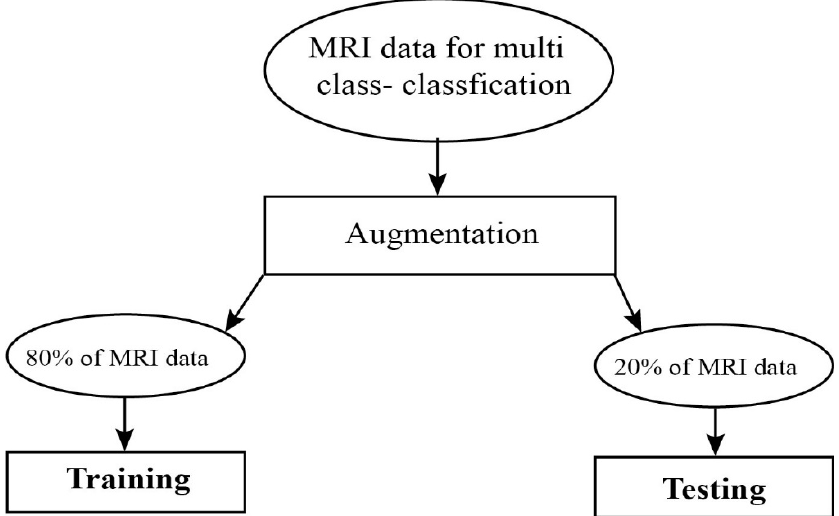
Figure 2. Proposed model data flow chat. Table 4. Proposed model confusion matrix on the OASIS data.